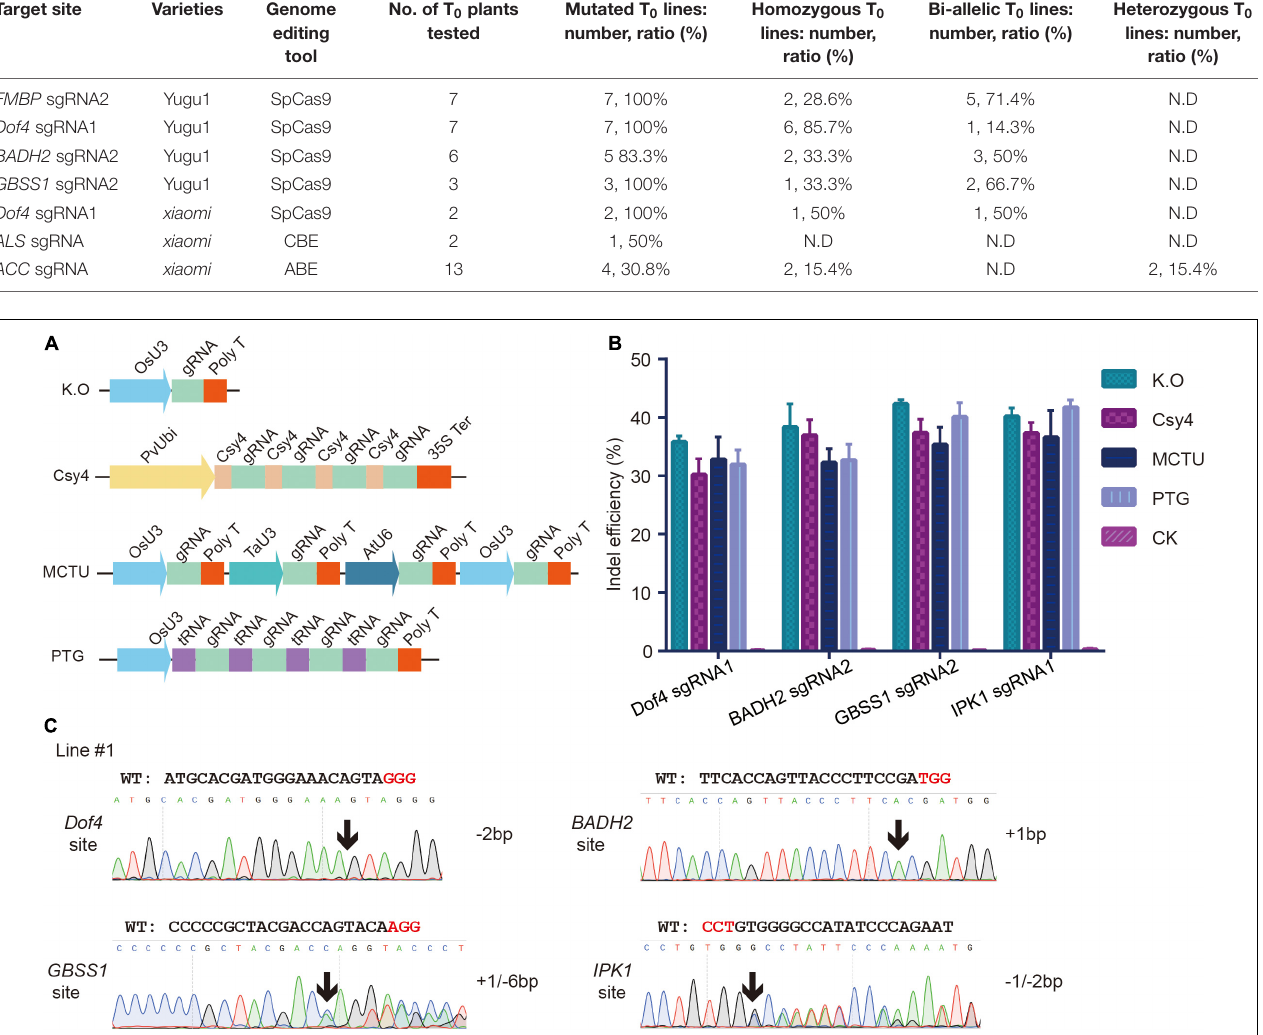
FIGURE 2 | Multiples genome editing in foxtail millet using the CRISPR/Cas9 system. (A) Different strategies for simultaneously expressing multiple single guide RNA (sgRNAs). (B) Comparison of mutagenesis frequencies at four sgRNA target sites induced by single knockout constructs and multiple (MCTU-, tRNA-, and Csy4- based) knockout constructs in protoplast assay. (C) Sanger sequence chromatograms of quadruple mutations at the Dof4 , BADH2 , GBSS1 , and IPK1 target sites of representative T 0 plants. The positions in which indels occurred were indicated by black